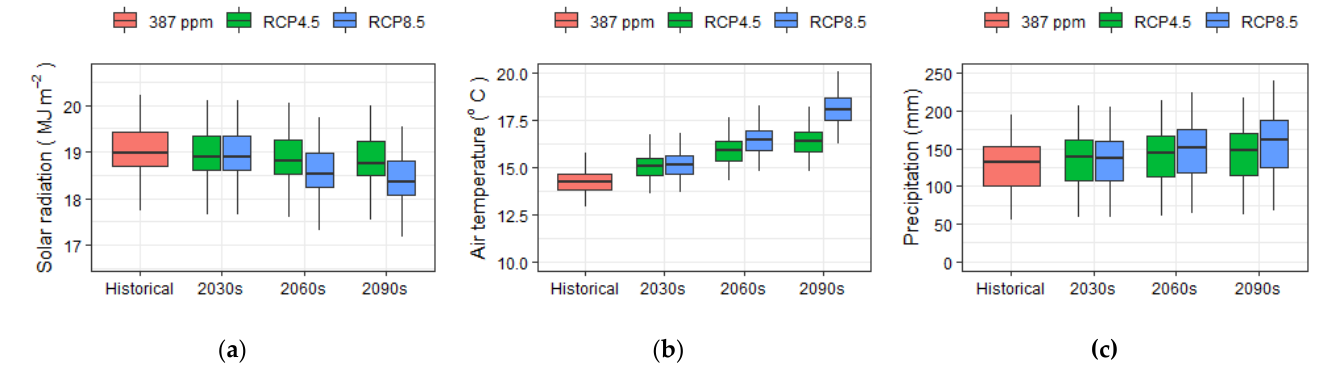
Figure 4. Projected change of ( a ) solar radiation (MJ m − 2 ), ( b ) mean air temperature (°C), and ( c ) precipitation (mm) based on the 15 GCM ensemble for the alfalfa growing season in the study area. Solar radiation has a projected minor decline under RCP4.5 (~0.21 MJ m − 2 by 2090s), and a bit larger decline under RCP8.5, starting by midcentury and reaching ~0.62 MJ m − 2 . The reliability of these projections is unclear, but they will contribute to changes in ETc, and the magnitude of these changes is not typically reported in the literature [55].